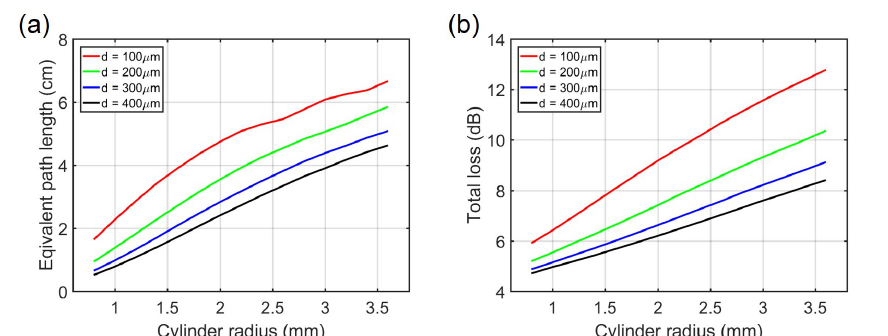
Figure 3. Simulation of the integrating cylinder with various cylinder radius and waveguide width combinations, the height of the cylinder is kept at 300 µ m. ( a ) Equivalent path length. ( b ) Total transmission loss.